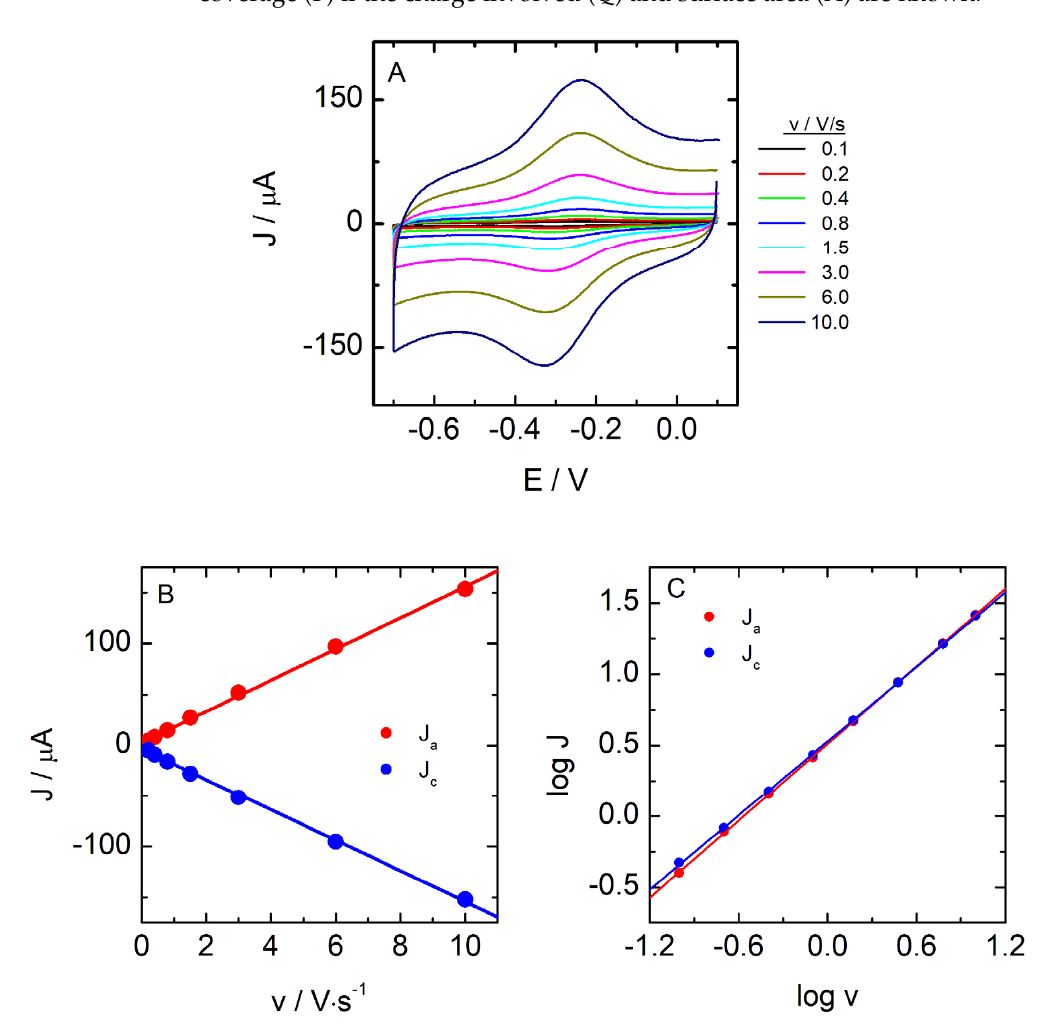
Figure 2. ( A ) Cyclic voltammograms of Hb-AuNT nanobioconjugates drop casted on a GC electrode at different scan rates in a 50 mM phosphate buffer at pH 7.4, ( B ) linear variation of the current against the scan rate, and ( C ) logarithmic plots for the anodic and cathodic currents. Q = n · F · A · Γ (2) The surface coverage determined at the lower scan rates is 2.17 × 10 − 10 mol/cm 2 , and decreases up to 7.02 × 10 − 11 mol/cm 2 at scan rates where the amount of charge becomes constant. Comparing to the theoretical monolayer coverage (5.18 × 10 − 12 mol/cm 2 ) for Hb and, considering that each unit is composed of 4 monomers with its corresponding heme group that could exchange 4 electrons, the amount of electroactive protein molecules is much greater than the corresponding to a monolayer, in particular, at the low scan rate regime. When analyzing the result at higher scan rates, the charge density corresponds to the monitorization of two to three layers of protein around the AuNT—that is, only the first two protein layers are involved in the electronic